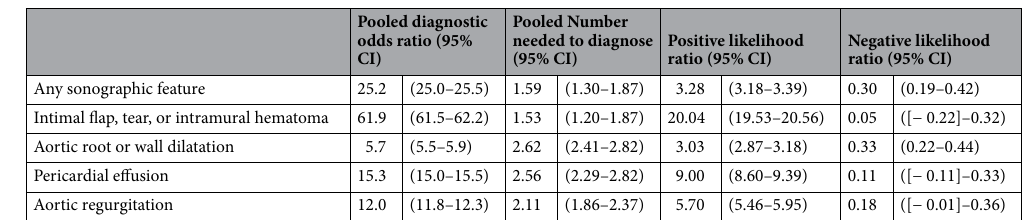
Table 3. Pooled diagnostic odds ratio, number needed to diagnose, and likelihood